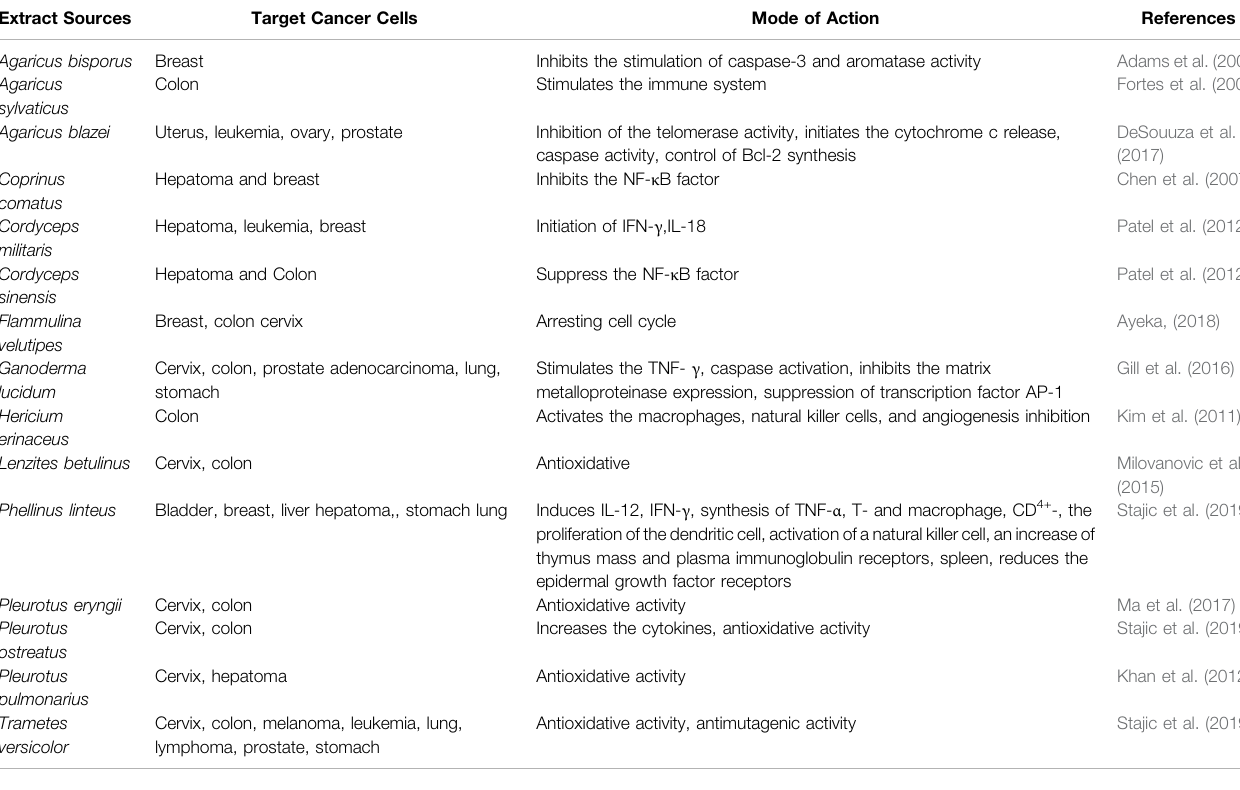
TABLE 4 | Biological activities of various mushroom extracts and mechanism of action.